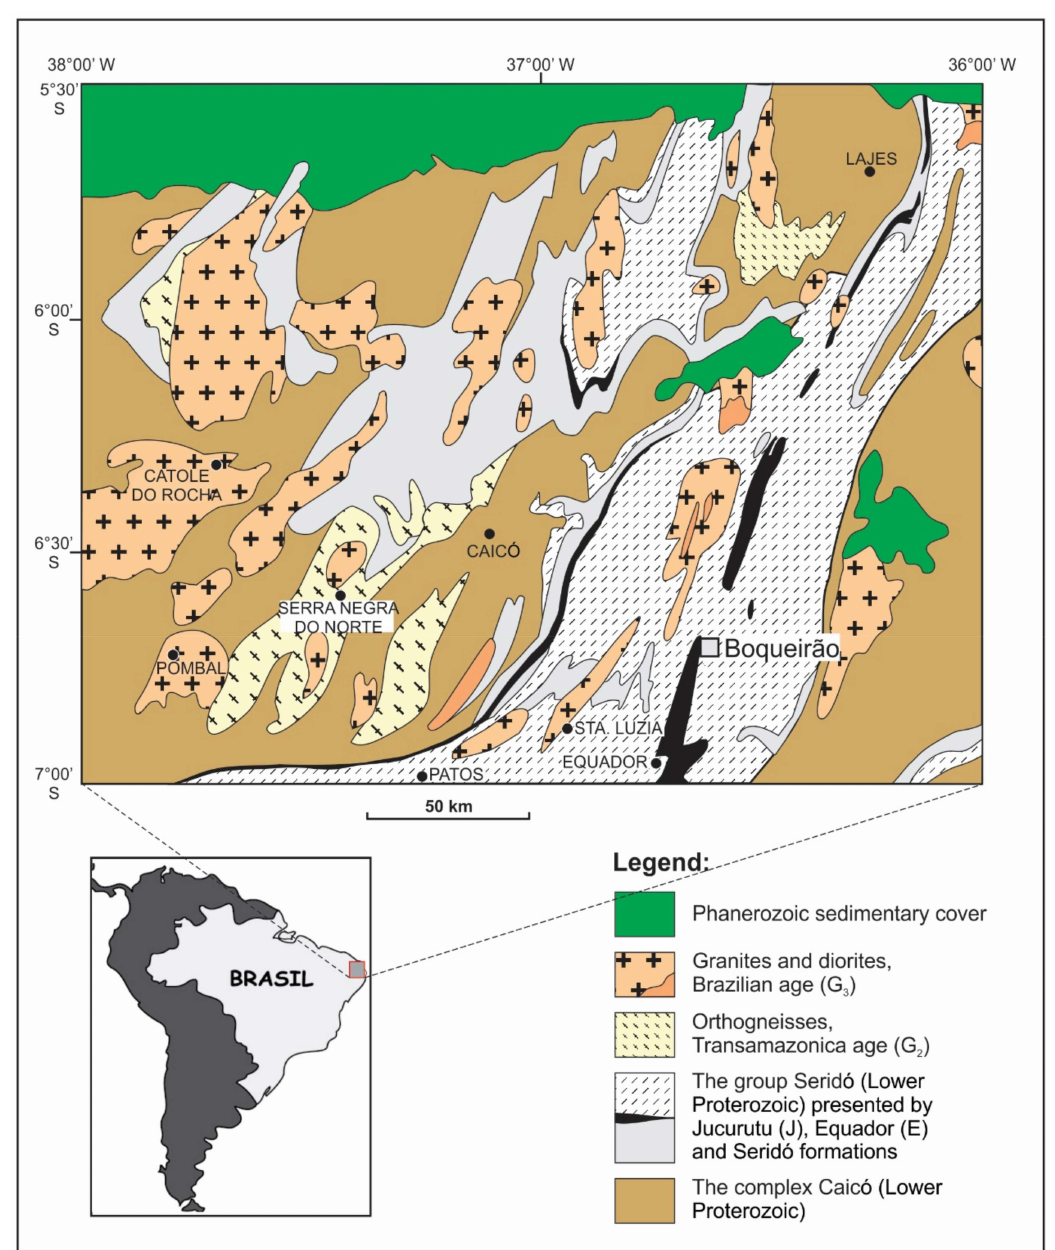
Figure 1. A simplified geological map of the Borborema Pegmatitic Province with the location of the Boqueir ã o granitic pegmatite, Parelhas, Rio Grande do Norte, Brazil. Adapted with permission from